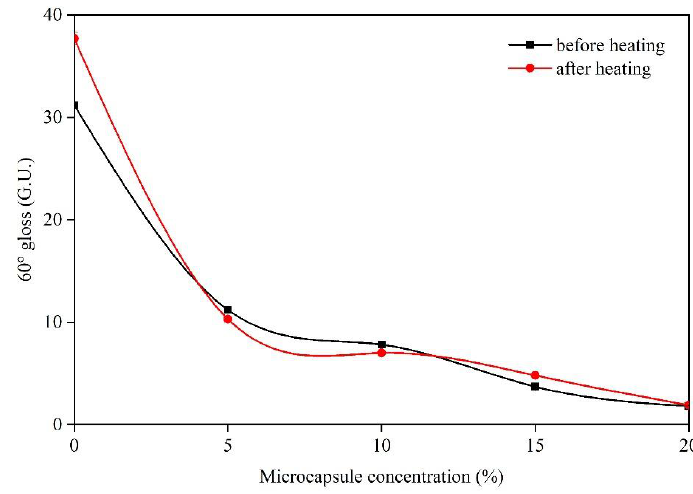
Figure 9. E ff ect of microcapsule with 0.75:1 core-wall ratio on the paint film Figure 9. Effect of microcapsule with 0.75:1 core-wall ratio on the paint film gloss.